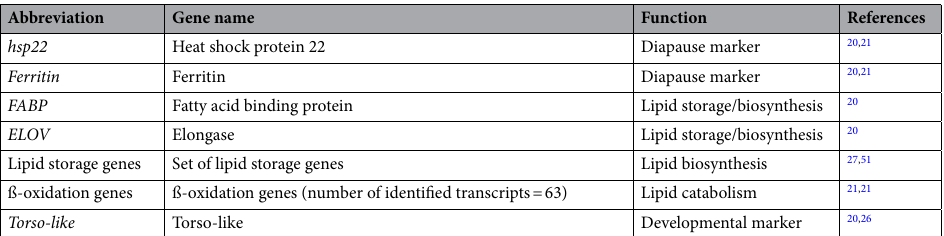
Table 1. Target genes involved in lipid metabolism/diapause/development selected for differential expression analyses (GLM) in Calanus finmarchicus exposed to a combination of presence or absence of a predator cue with high or low food